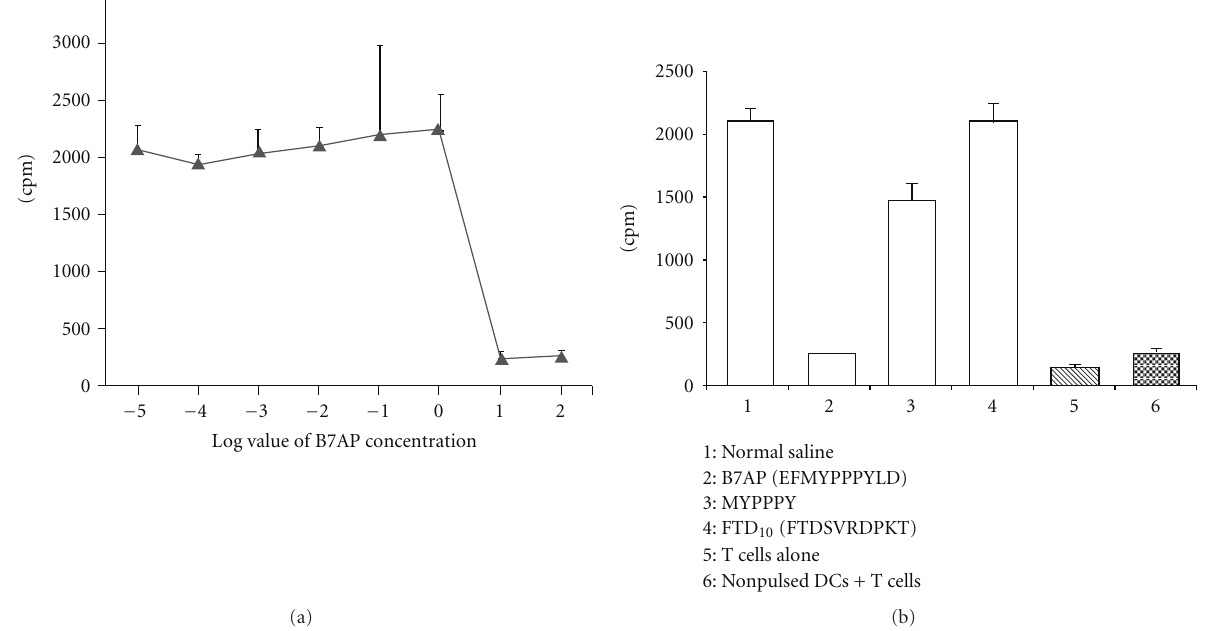
Figure 3: B7AP-pretreated DCs inhibited T-cell proliferation in MLR. Under high concentrations of B7AP (100 mg/L), T cells demonstrated a low proliferation capacity. However, proliferation of T cells surged to a rather high level when the final concentration of B7AP went down from 10 mg/L to 1 mg/L, followed by a plateau (a), indicating that B7AP final concentration of 10mg/L could ensure maximal blockage of DC surface B7 molecules. The BM-DCs were pretreated by the B7AP and control peptide at the same concentration (10mg/L), and the MLR was performed as described above (b). NS: normal saline group, MYPPPY group: relative peptide, FTD10 (FTDSVRDPKT) group: negative control